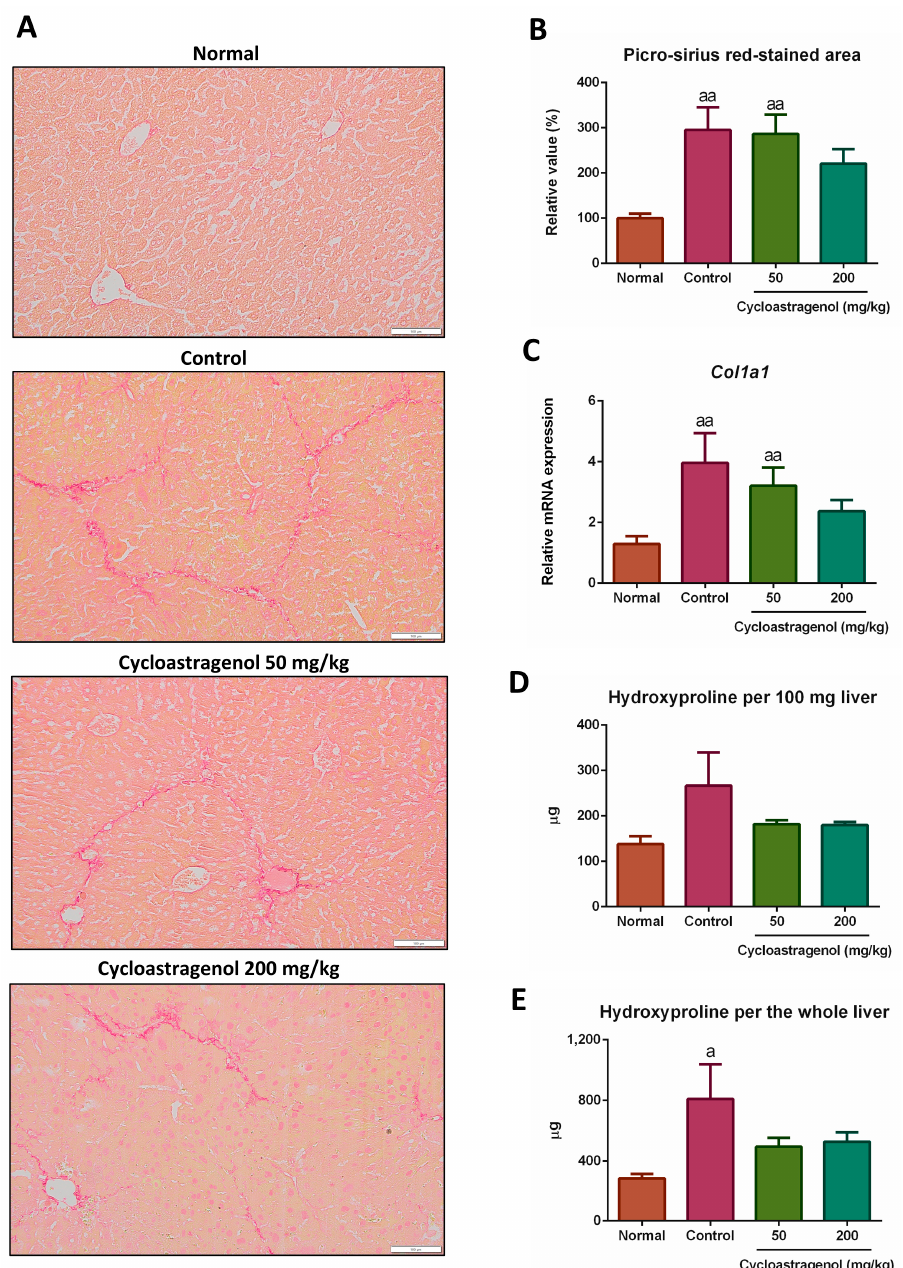
Figure 1. Anti-fibrotic efficacy of cycloastragenol (50 mg/kg and 200 mg/kg) in the liver of mice treated with carbon-tetrachloride. Representative picro-sirius red-stained pictures of the liver among each group ( A ) are shown. The stained areas of picro-sirius red ( B ) and relative mRNA expression of collagen type 1 ( Col1a1 , ( C )) when compared with the normal are shown. Hydroxyproline contents of the liver when calculated per 100 mg liver tissue ( D ) and per the whole liver ( E ) are shown. Scaled bar = 100 µ m. Bar graphs and corresponding error bars indicate means and SEM among the same treatment, respectively (n = 8–10). a and aa indicate p < 0.05 and 0.01 when compared with the normal, respectively.